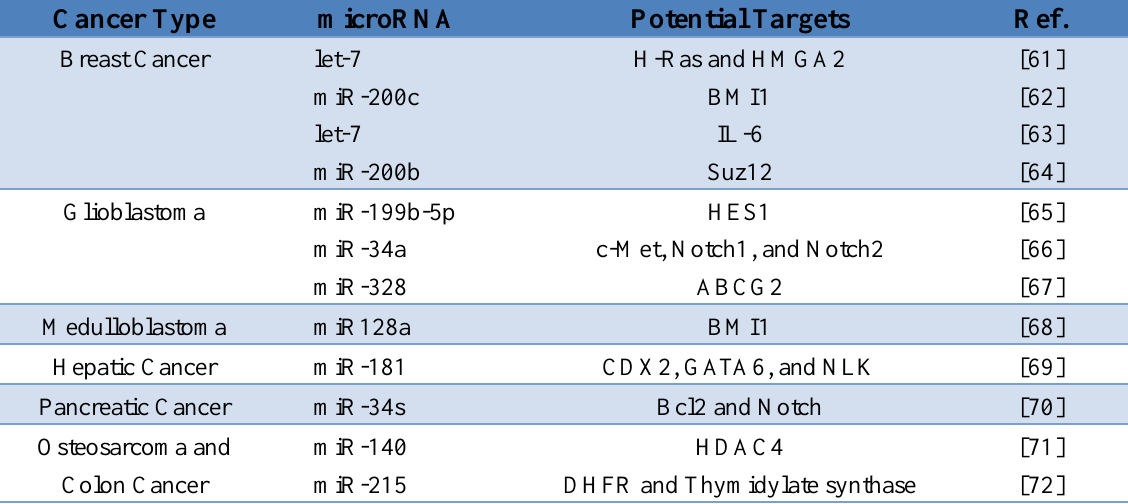
Table 2. miRNAs Regulate the CSC